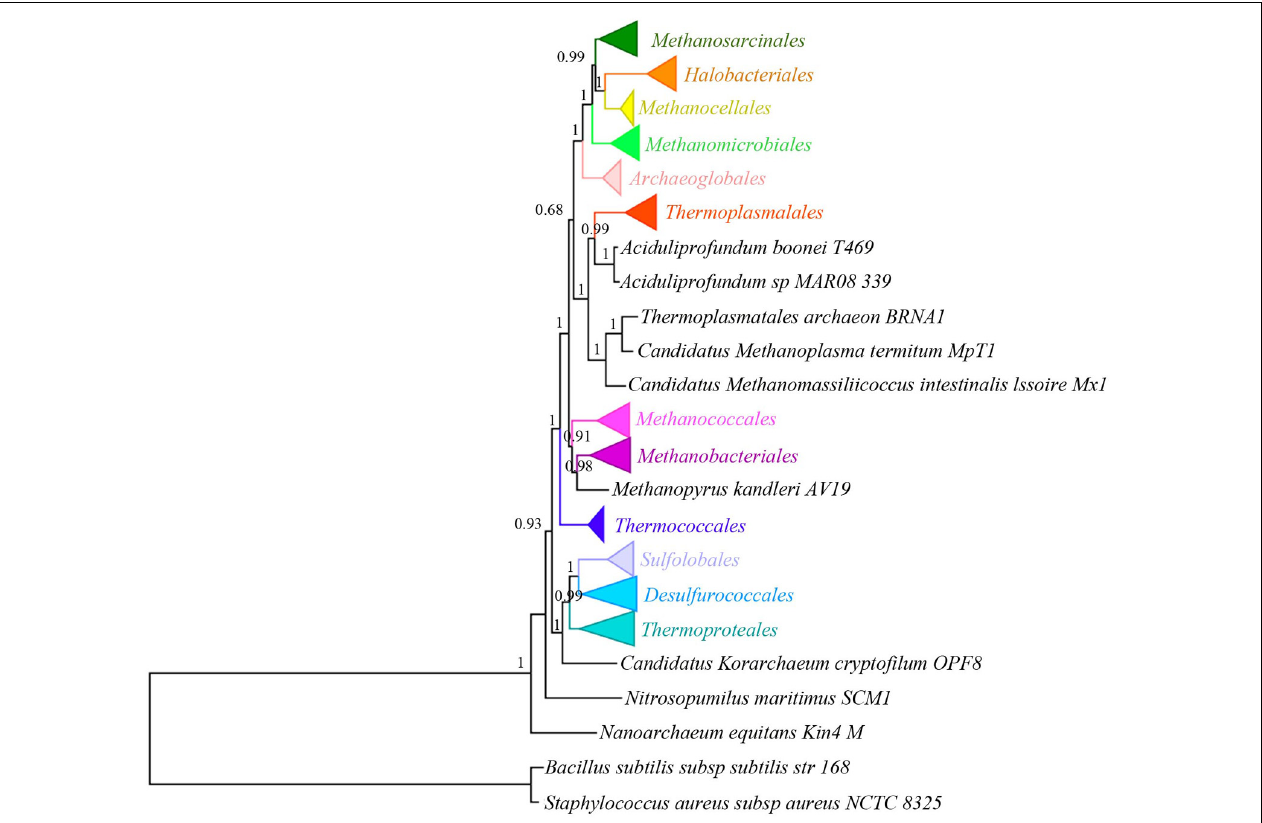
FIGURE 1 | Phylogenetic analysis of 167 archaeal genomes and two bacterial genomes with LG+G+I model. The tree was constructed by ML method using a supermatrix of amino acid sequences (169 × 3509 sites) from ClustalW alignment. Different large clades are in different color. Numbers on the nodes are aLRT SH-like values, which show reliability of corresponding branches. Because some clades have a large number of branches, they are collapsed and the complete tree could be found in Supplementary Figure S1